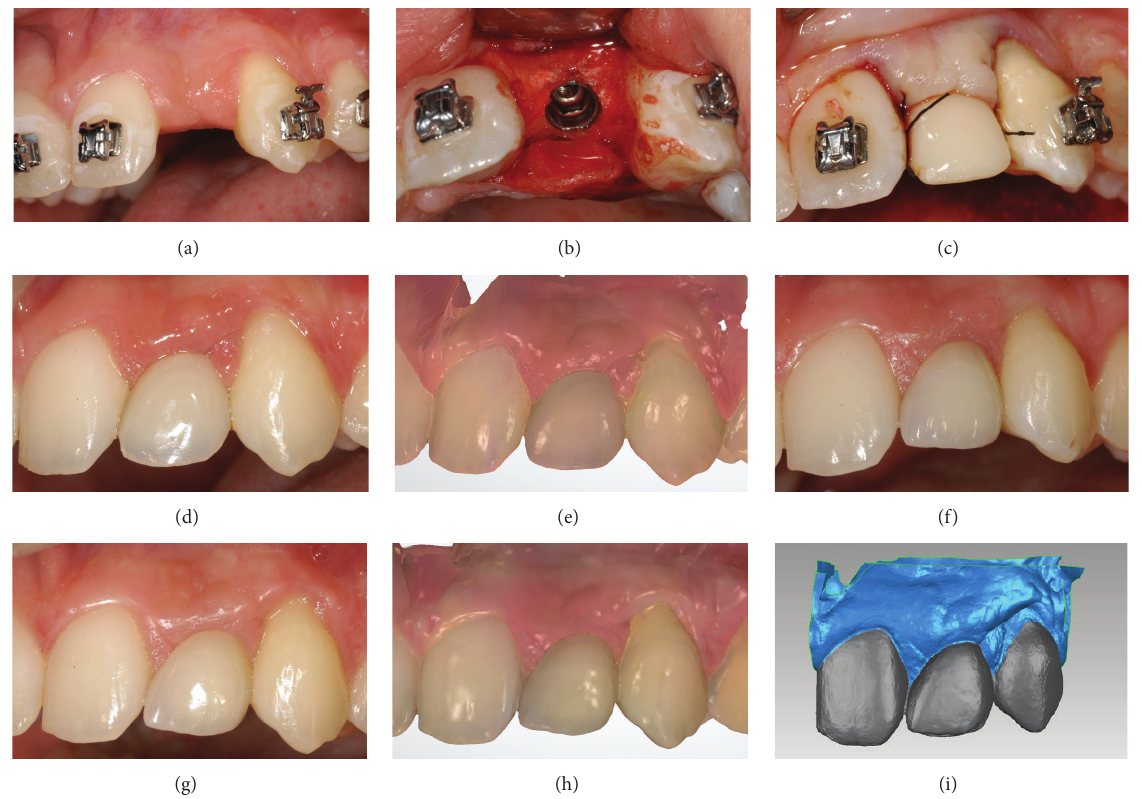
Figure3:Conventionalimplantplacementinhealedridge( control group)ofayoungfemalepatient(19yearsold)whounderwentorthodontic treatment: (a) preoperative situation; (b) the mucoperiosteal flap was raised, the alveolar bone was exposed and the implant